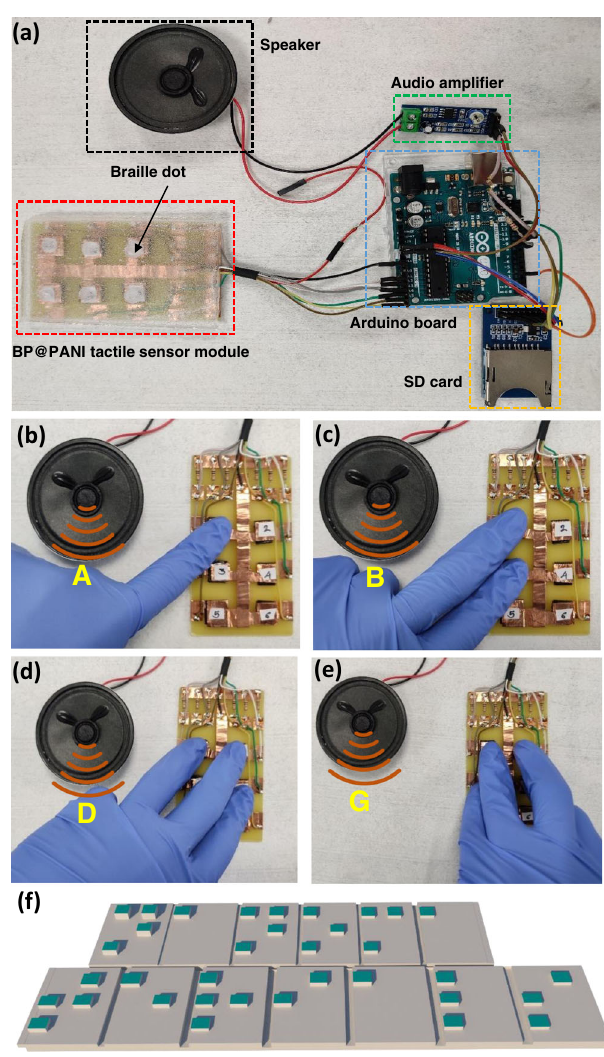
Fig. 5 | BP@PANI-based tactile sensor for auditory feedback. a Digital photo- graphof six-pixelBP@PANI-based tactilesensorarray forpress-to-audio feedback. b - e Digital photographs of diverse braille alphabet patterns converted to audio signals. f Press-to-audio illustrates converting braille pattern “ nanomaterials ” to audio